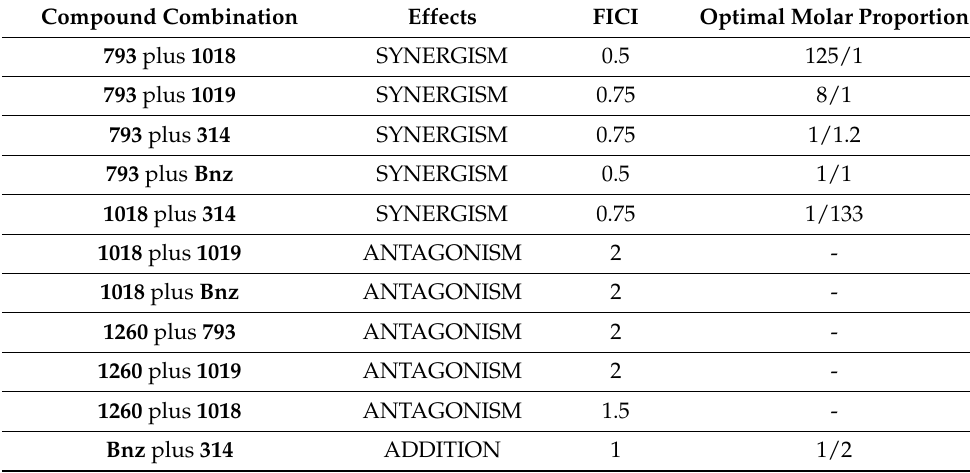
Table 4. Isobolographic analysis of the tested combinations. The optimal molar proportion was derived from the isobolagraphic